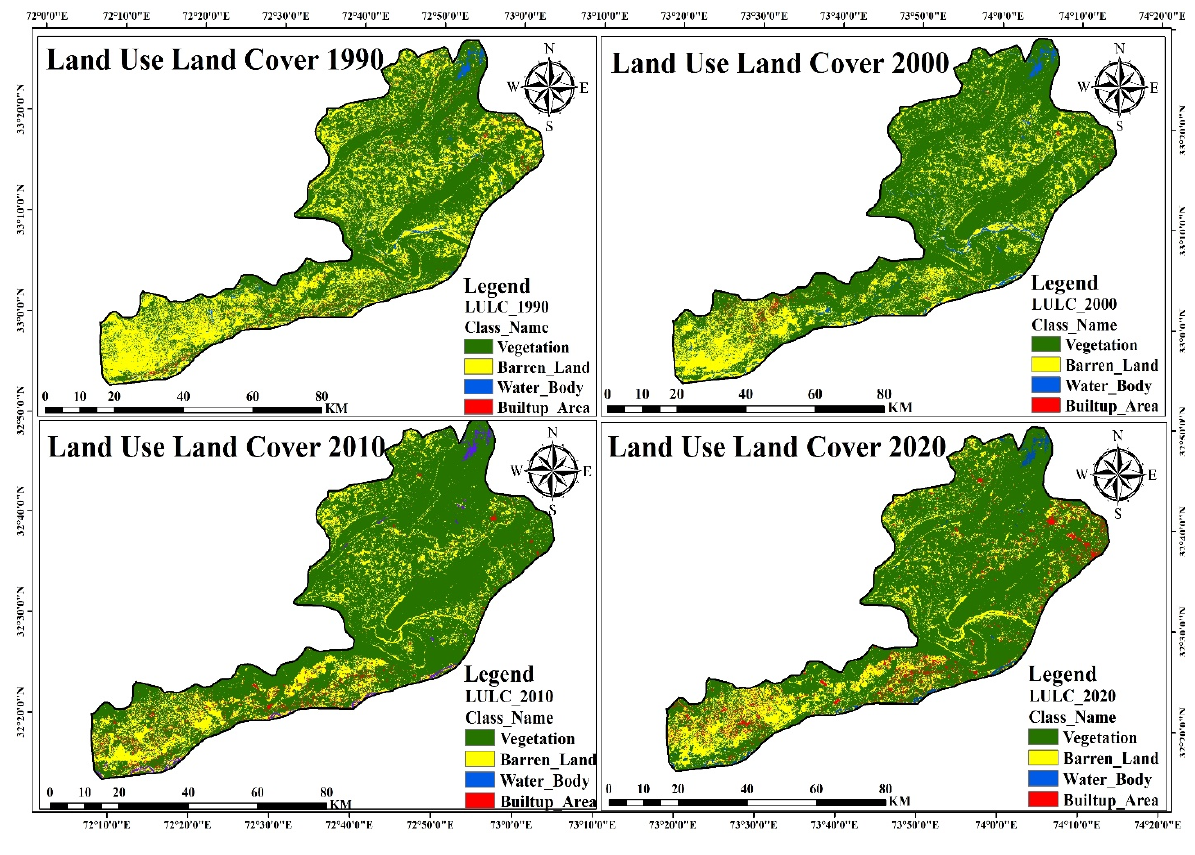
Figure 6. Land use–land cover maps of the district.